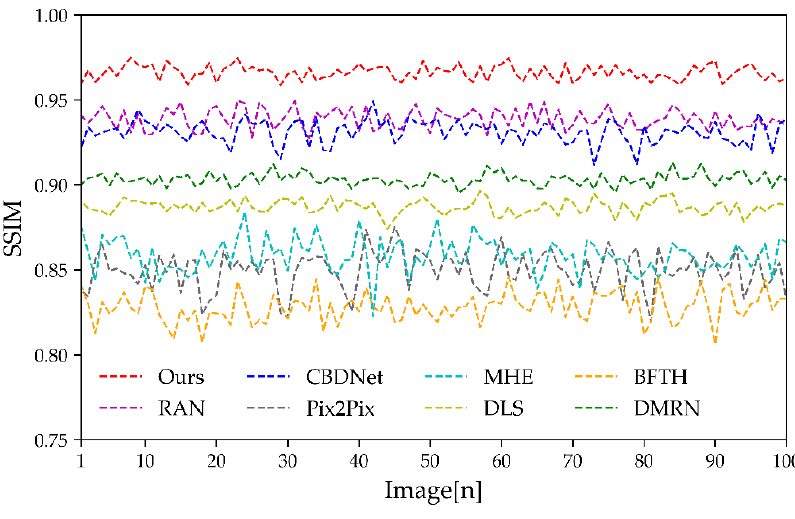
Figure 22. SSIM of test dataset.